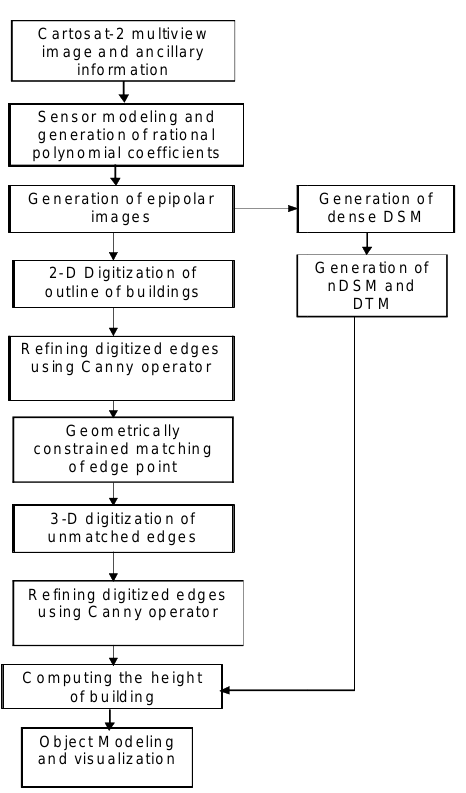
Fig 7: Block diagram of site model generation system.